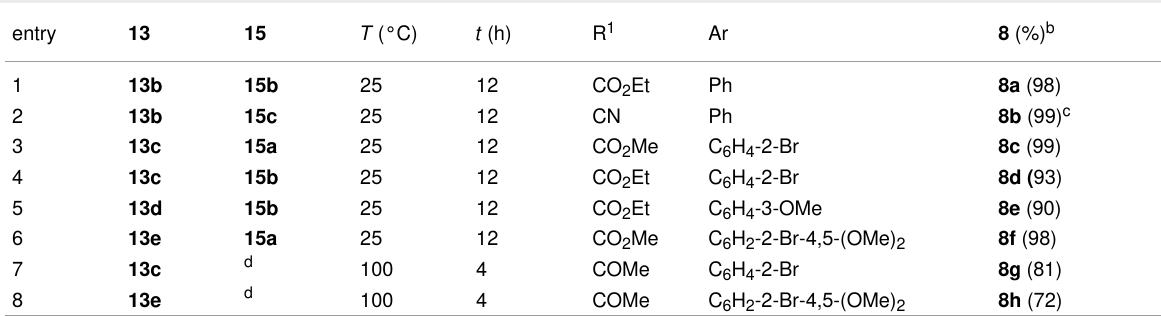
Table 1: Preparation of 1,2-substituted pyrroles 8a – h . a